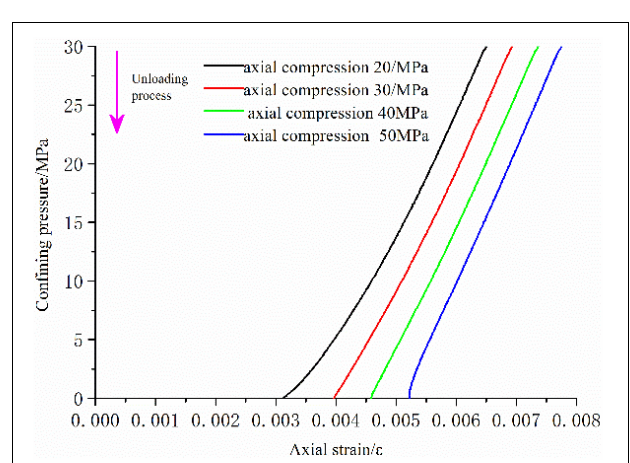
failure characteristics after the peak in the stress–strain curve.